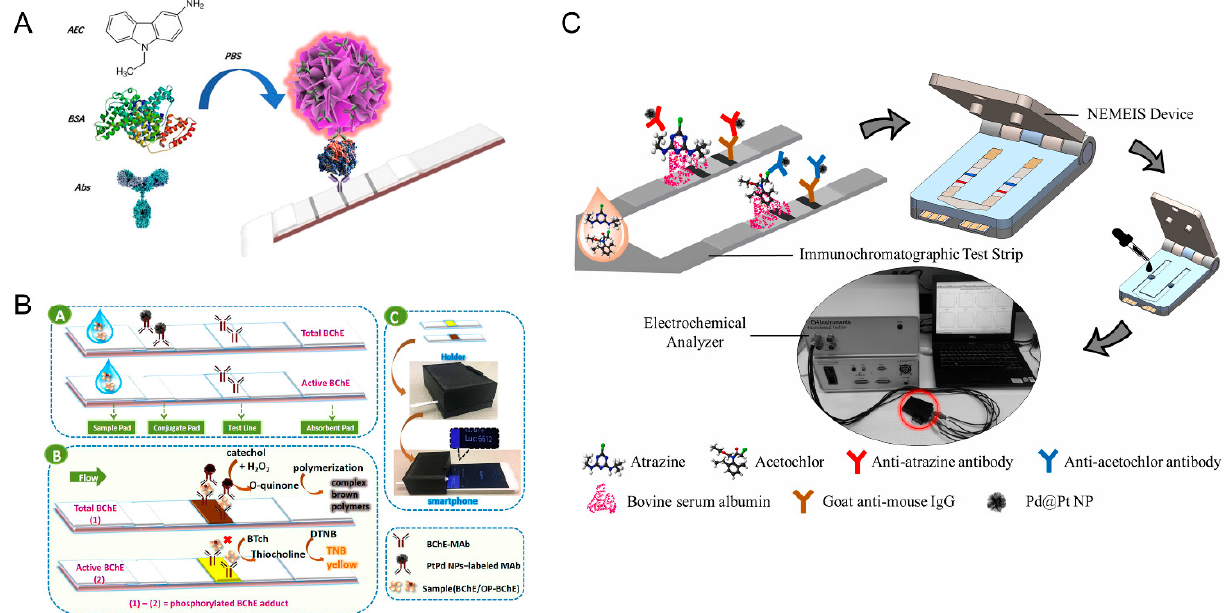
Figure 2. ( A ) Scheme of the detection principle of cardiac biomarkers based on SANs-lateral flow